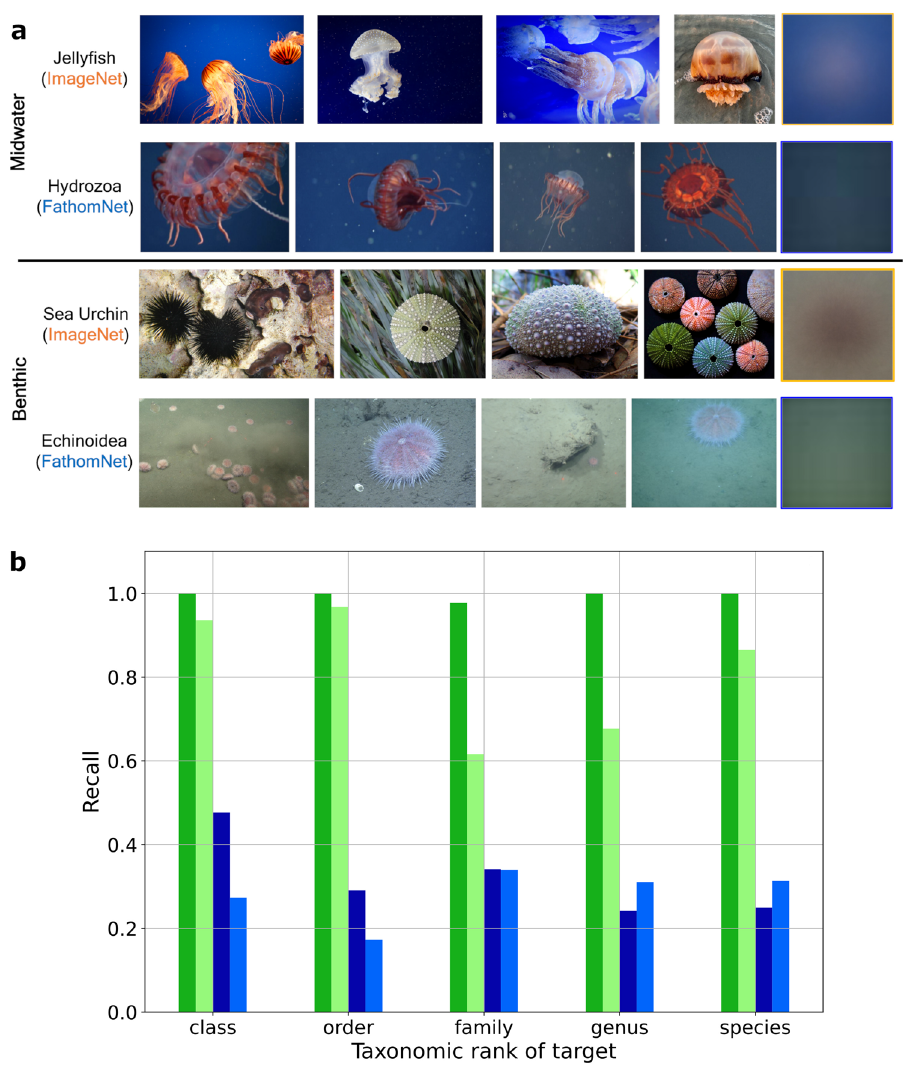
Figure 5. Dataset visualizations contextualizing FathomNet relative to ImageNet. ( a ) The average pixel values of images in ImageNet and FathomNet. Images from a midwater and benthic concept in ImageNet (hosted on Flickr) were approximately matched to concepts available in FathomNet, and an equal subset of images from both repositories were resized and averaged pixel-wise (far-right column). The uniform image patches from FathomNet suggest that there is more diversity in poses and object sizes relative to labeled data from ImageNet. FathomNet image credits: MBARI. ( b ) Concept coverage at different taxonomic ranks within FathomNet. Fifty FathomNet images were selected randomly at each level of the taxonomic tree and checked for annotation completeness by a human expert. Green bars correspond to the midwater concept Bathocordaeus mcnutti and blue bars correspond to the benthic concept Gersemia juliepackardae . Darker colors are the target concept and lighter colors are any other concepts present in the frame. Benthic images are typically missing more annotations than those from midwater